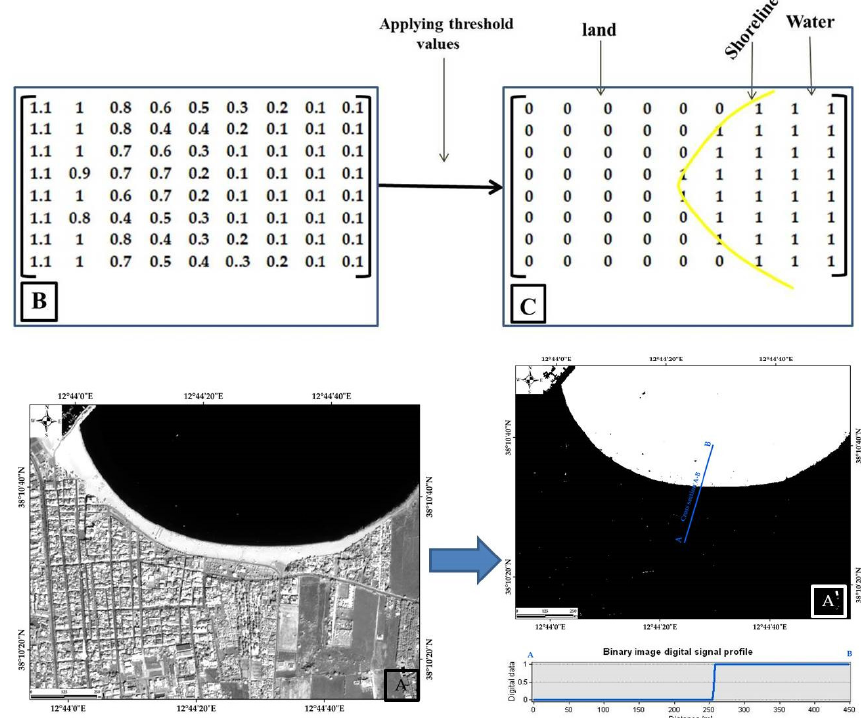
Figure 5. Band matrix representation ( B ), illustrating original GeoEye-1 NIR band ( A ) on which threshold reflectance values were applied to build a binary image ( A’ ). The position of the shoreline can be identified at the intersection of 1 and 0 as represented on matrix representation ( C ) of a binary image or in the contact of land and water represented in the binary image by zeros and ones, respectively (A’). The binary image digital signal profile revealed the edge between land and water. This edge was detected by the raster to vector (R2V) algorithm and was used for the vectorization